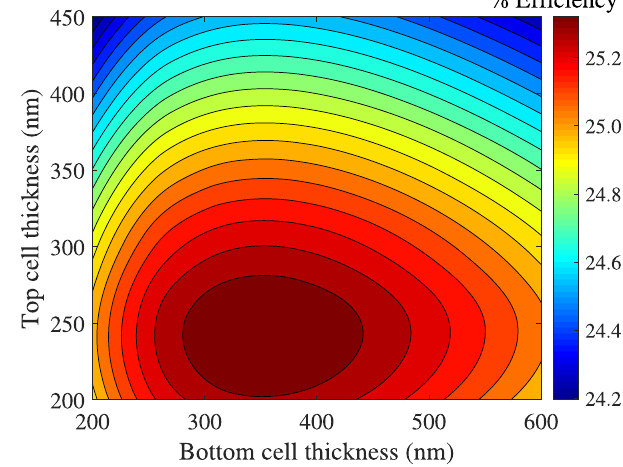
Fig. 12. 4T tandem solar cell ef fi ciency for different thicknesses of top and bottom cells considering trap-assisted recombination losses. The top and bottom cell bandgaps are fi xed at 1.82eV and 1.2eV, respectively. Interface and bulk traps are considered in both the